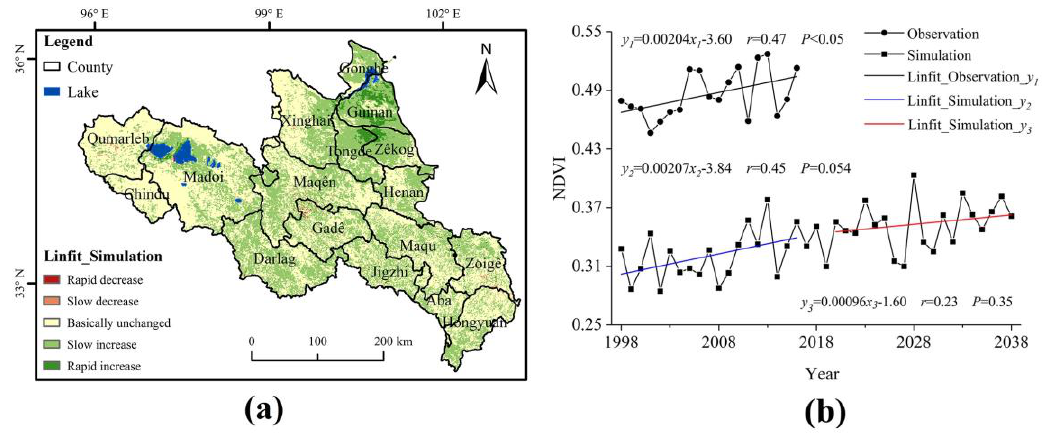
Figure 8. Prediction of the NDVI trend from 2020 to 2038: ( a ) spatial distribution; ( b ) temporal series. In the Figure 8a, rapid decrease represents a slope < –0.003; slow decrease represents –0.003 < slope < –0.001; basically unchanged represents –0.001 < slope < 0.001; slow increase represents 0.001 < slope < 0.003; rapid increase represents a slope <